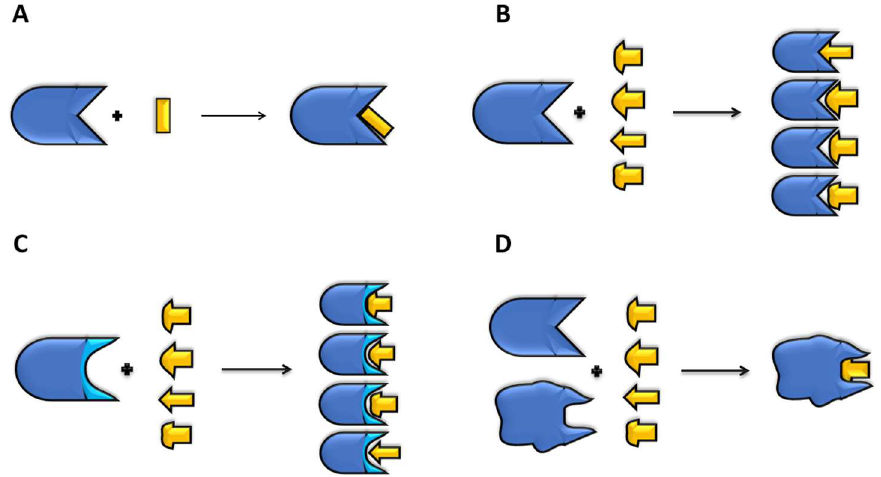
Figure 2. Different levels of docking simplification. ( A ) Rigid docking: neither the receptor (blue) nor ligand (yellow) are allowed to change conformation during the docking process. ( B ) Rigid receptor, flexible ligand: only the small organic molecule (ligand) is allowed to change conformation. Different shapes represent different conformations of the same ligand molecule. The algorithm explores different poses and determines the best score. ( C ) Semi-flexible docking: in addition to the ligand flexibility, the receptor is allowed to change the conformation of a few residues in the binding pocket (cyan) to facilitate ligand interaction. ( D ) Flexible docking: both receptor and ligand are free to change conformation, to improve receptor–ligand matching. Different shapes represent different conformations of the receptor (blue) or ligand (yellow).